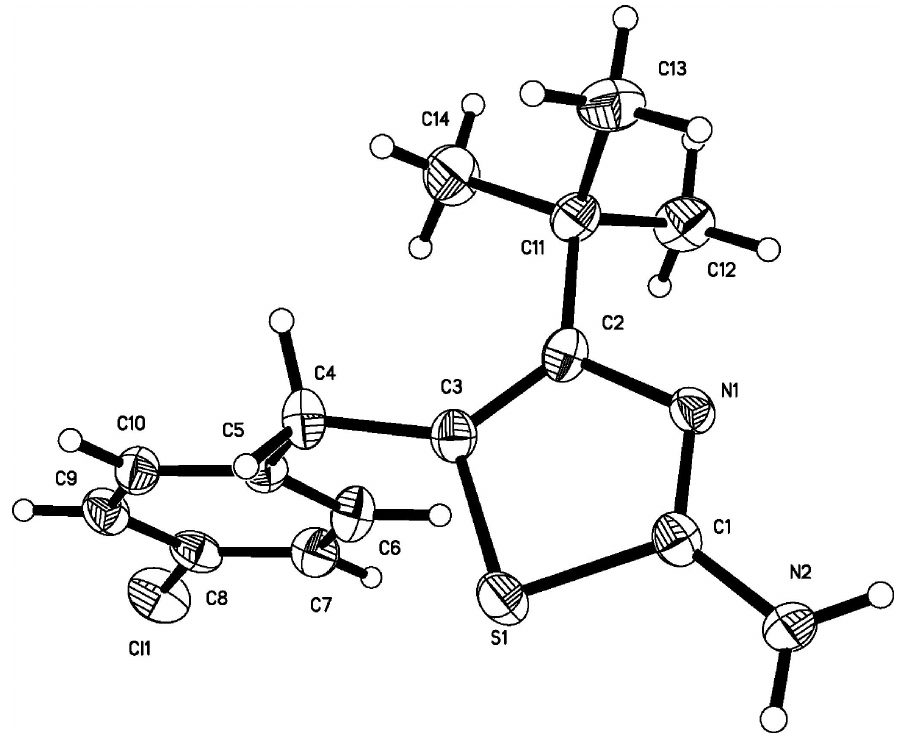
Figure 1 Molecular structure showing 30% probability displacement ellipsoids.H atoms are drawn as spheres of arbitrary radii. Only the major occupied sites of the disordered tert -butyl group are